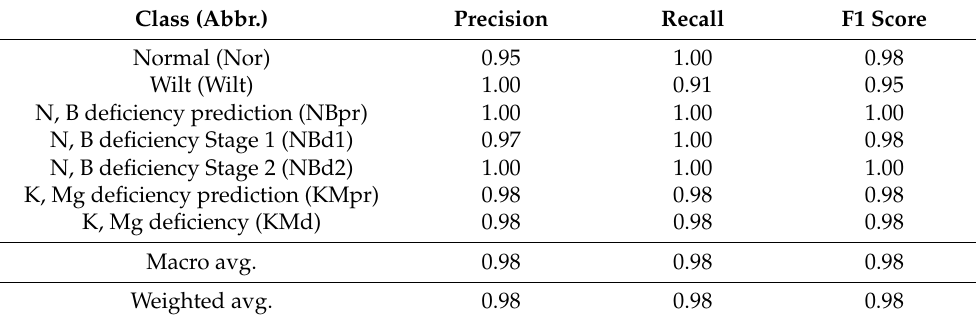
Table 3. Performance evaluation index according to plant physiological